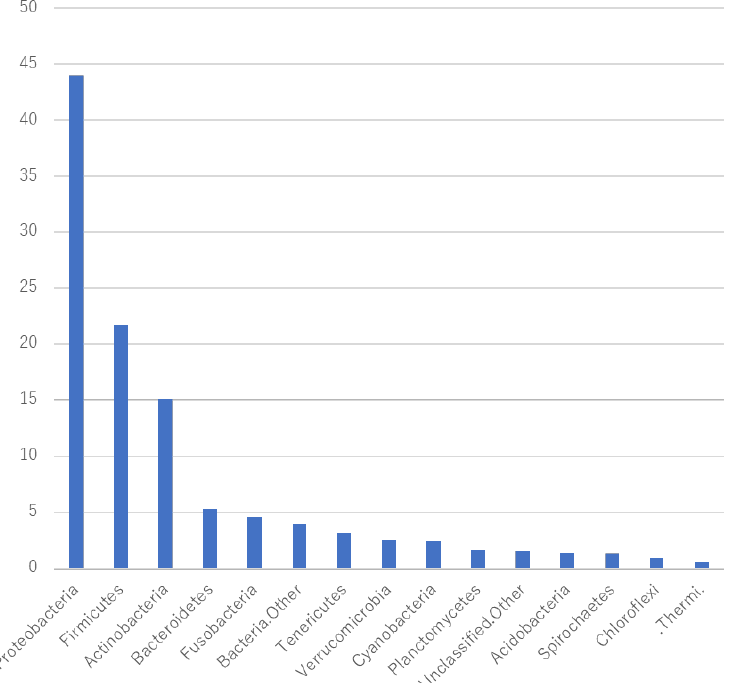
Figure 2. The results of mining the characteristic variance of the groups that were determined using i-means.